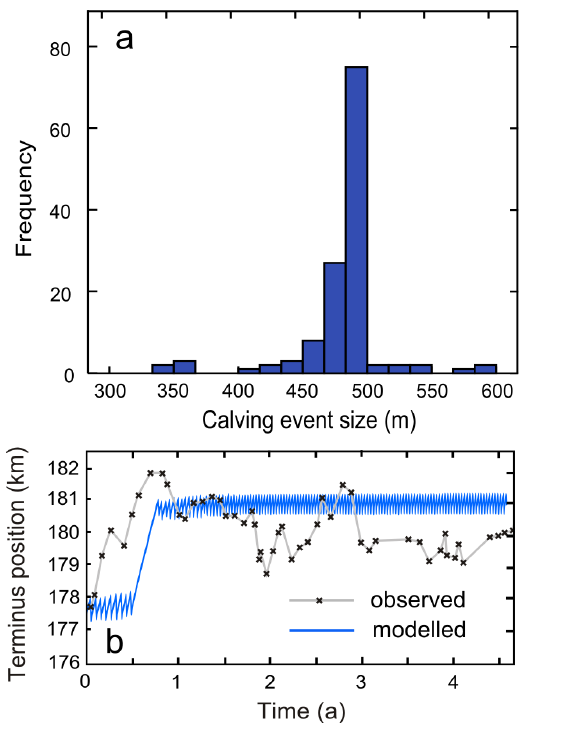
Fig. 2. Model output for 5yr run with no seasonal inputs. (a) His- togram of calving event sizes (b) Comparison of modelled and ob- served terminus